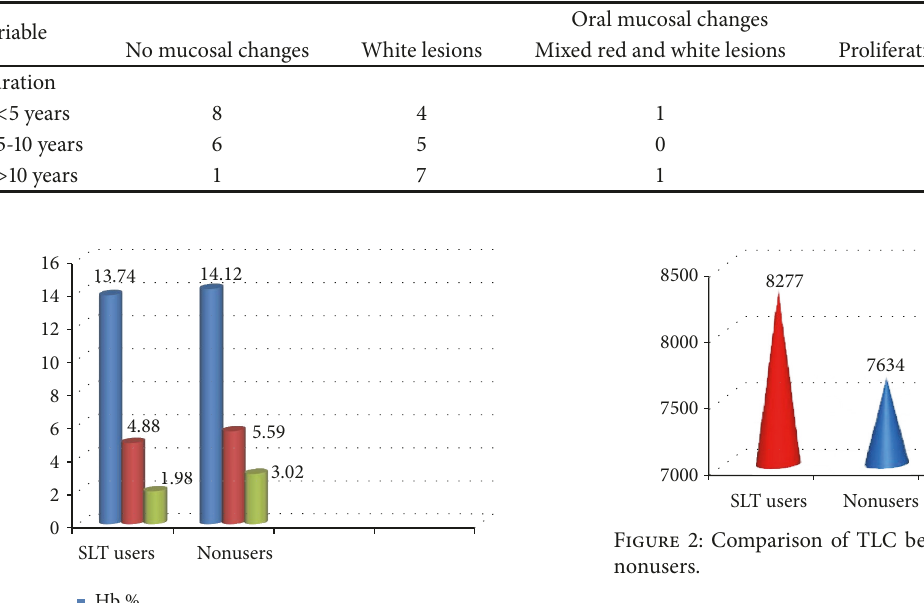
Table 2: Distribution of oral mucosal changes seen in SLT users according to duration of consumption.